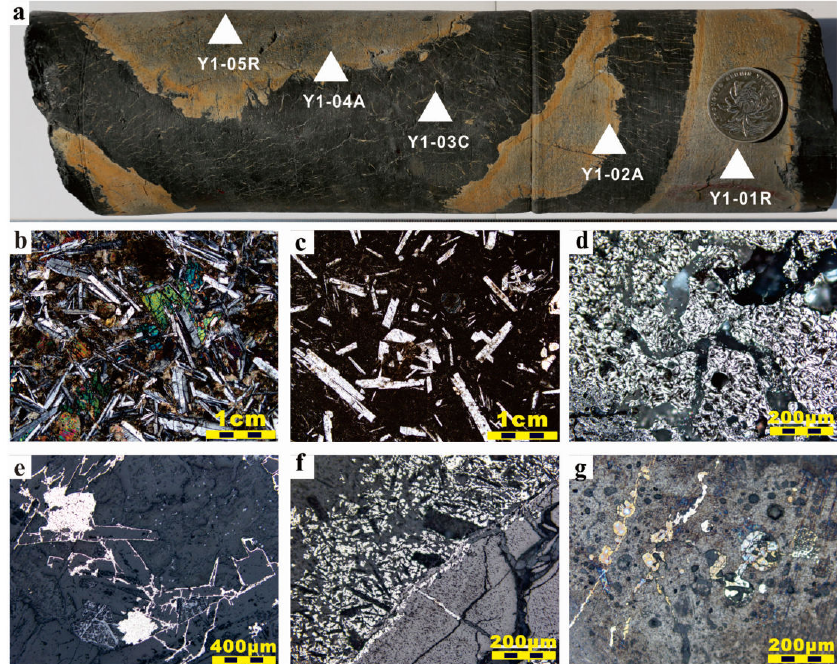
Figure 2. Photographs and photomicrographs of intrusion-related cokeite and pyrite from the Yuandian Coal Mine. ( a ) Hand-specimen of magma cokeite in seam VIII; ( b ) photomicrograph of a diabasic sill (Y1-01R) (+); ( c ) photomicrograph of a diabasic sill (Y1-02A) ( − ); ( d ) photomicrograph of cokeite (Y1-03C) (reflected light); ( e ) photomicrograph of coarse-grained pyrites in diabase (Y1-05R) (reflected light); ( f ) photomicrograph of fine-grained pyrites in metamorphic aureole (Y1-04A) (reflected light); ( g ) photomicrograph of spherical pyrites in cokeite (Y1-03C) (reflected